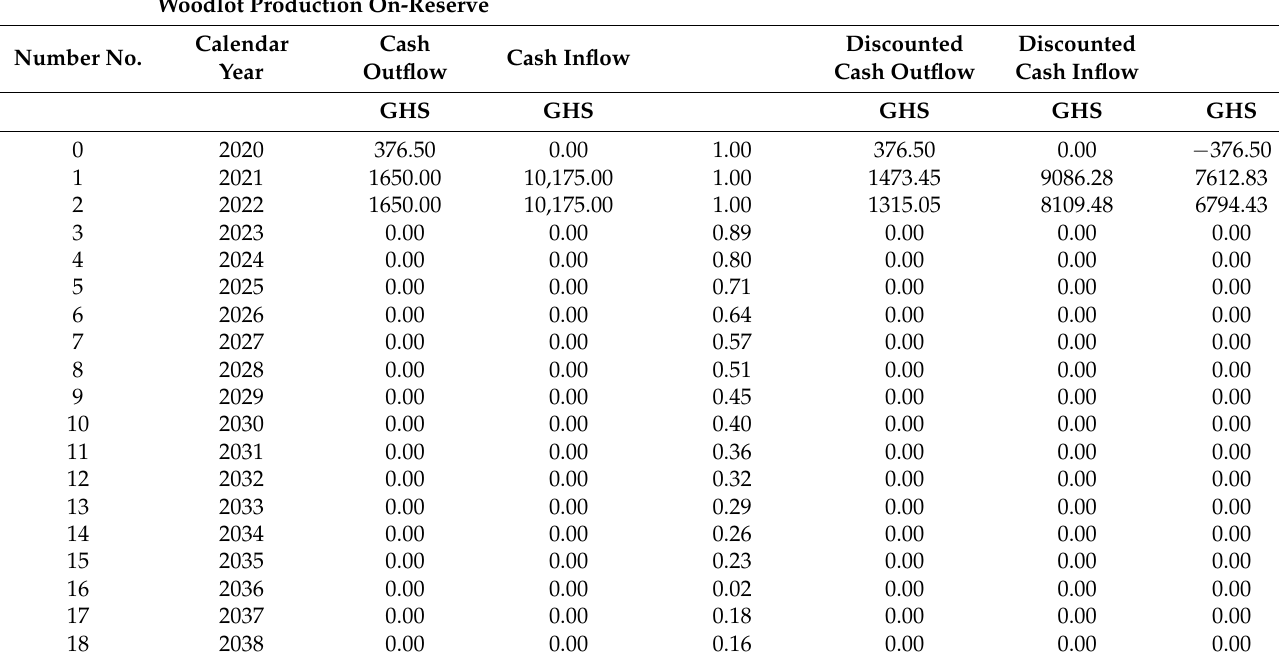
Table A7. Profitability of woodlot farmers (on reserve). Woodlot Production